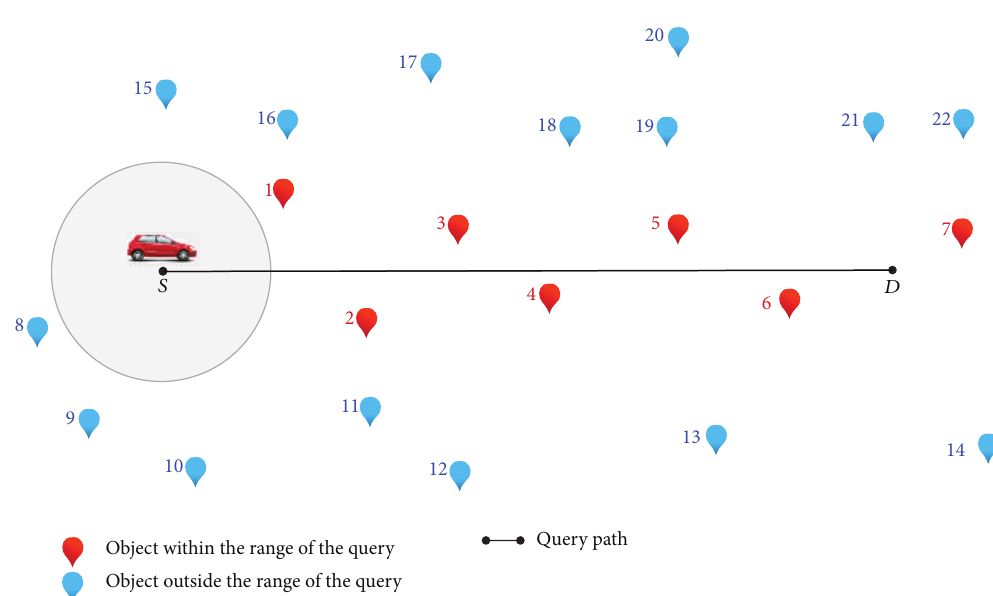
Figure 2: An example of moving range search query in mobile